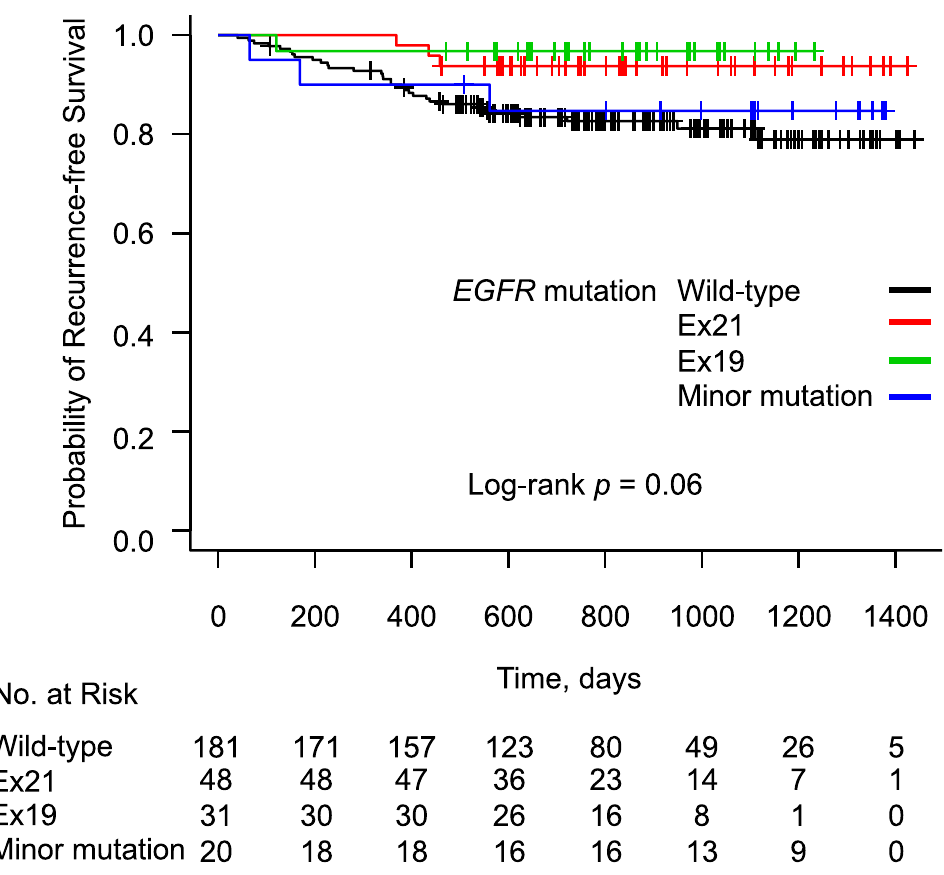
Figure 2. Kaplan–Meier curve showing the probability of a recurrence-free survival among patients after lung cancer resection according to the EGFR mutation status.